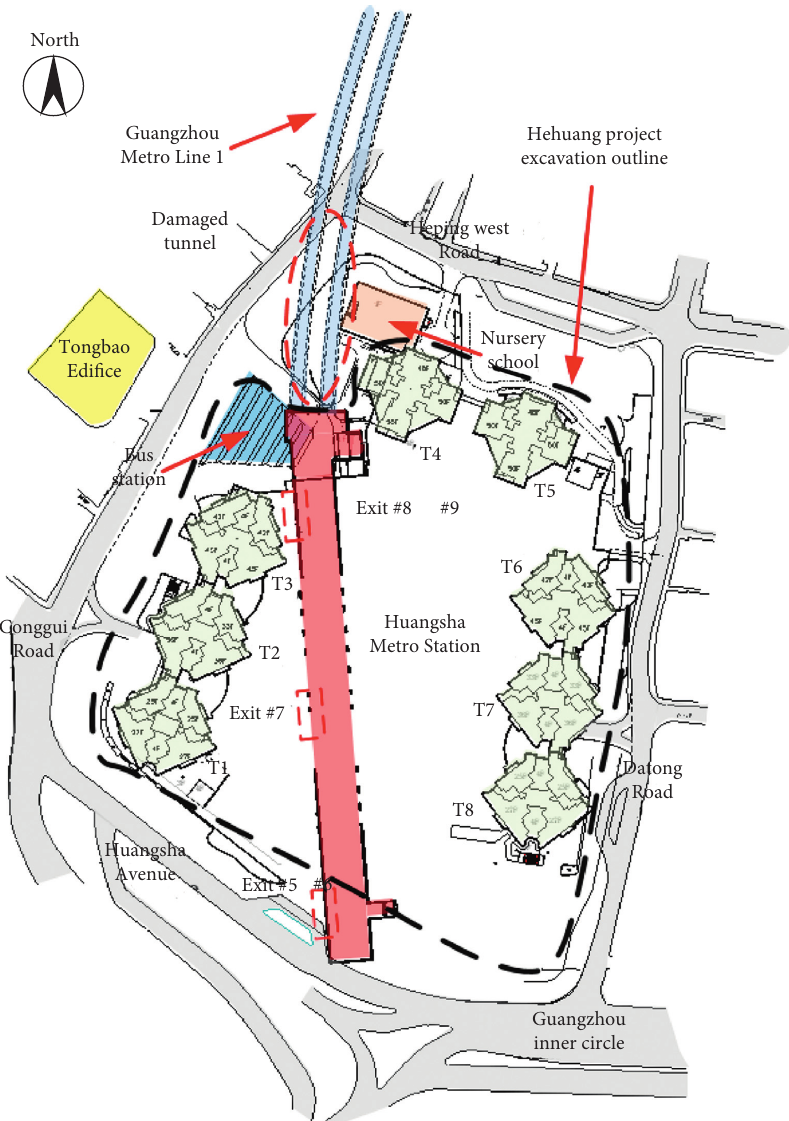
Figure 1: Plan layout of the